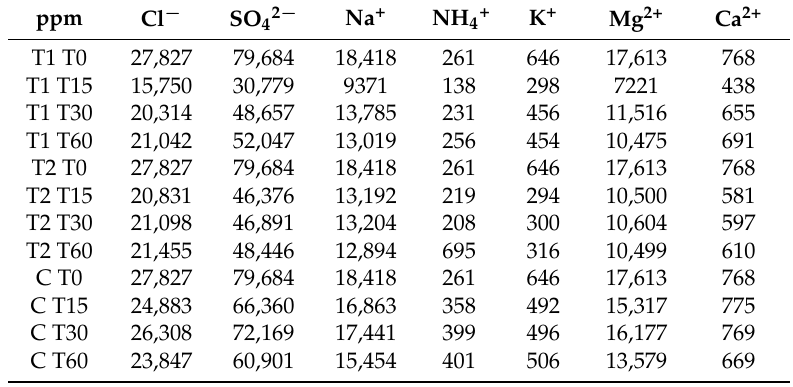
Table 1. Evolution of the ionic water composition (ppm) in controls (C) and microbial mat (T1 and T2)